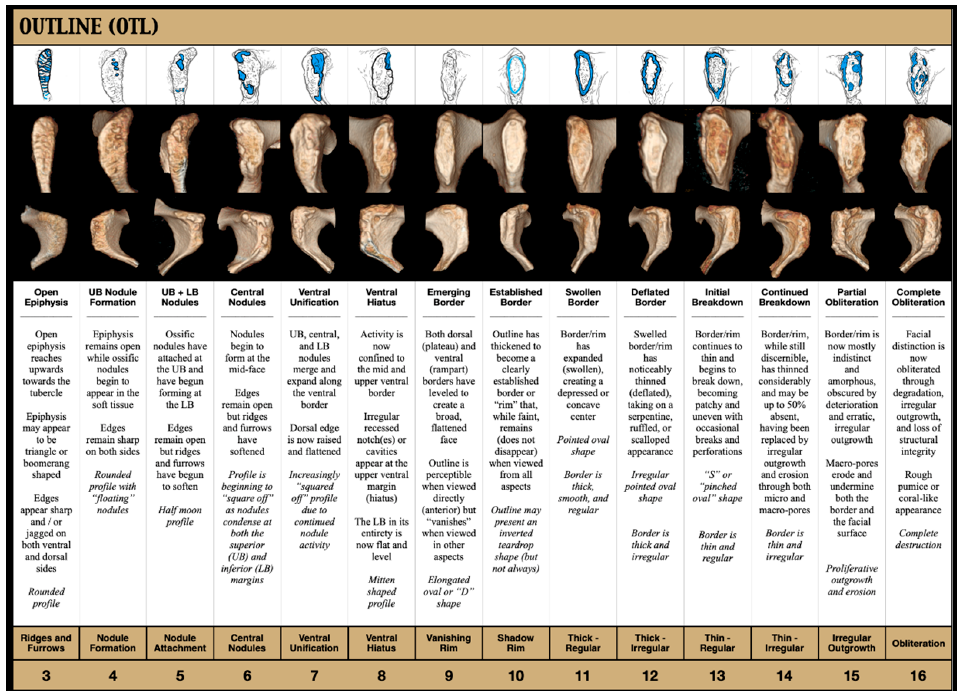
Figure 6. The Outline.